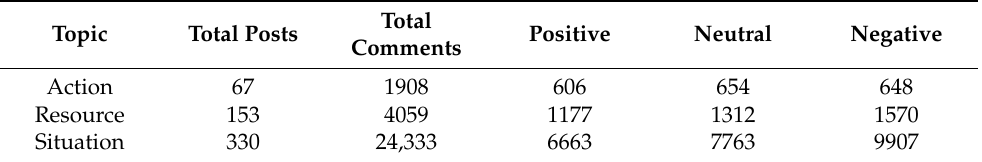
Table 8. Summary of Facebook posts, comments, and comment sentiment by topic for Healthy Canadians, CBC News, and CTV News